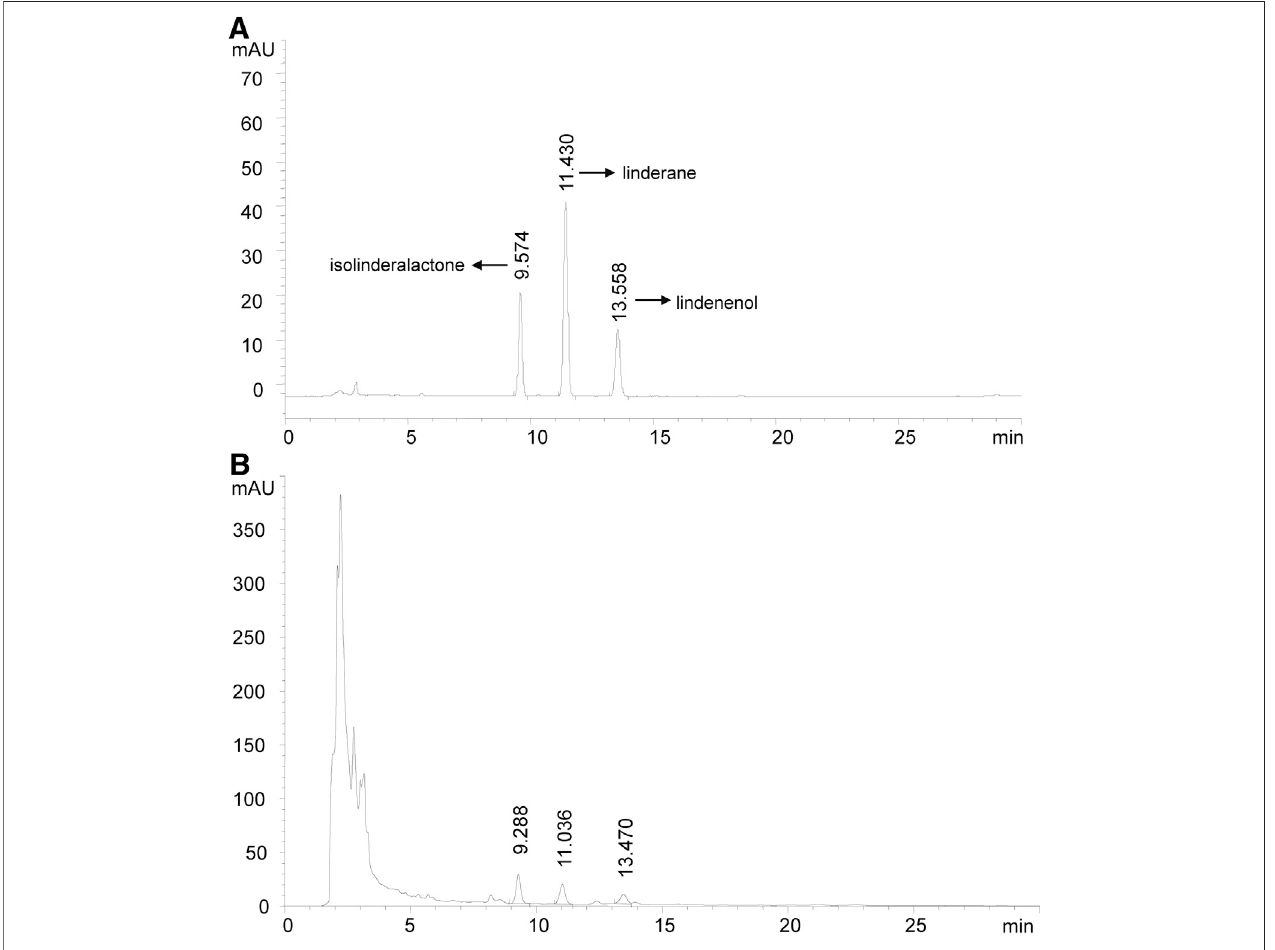
FIGURE 1 | High-performance liquid chromatography chromatogram (HPLC). Isolinderalactone shows the earliest peak time. Therefore, the description of FIGURE 1A needs to be modi fi ed as follows. (A) The HPLC pro fi le of standard isolinderalactone, linderane,and lindenenol are shown with a peak of 9.574, 11.430, and 13.558 min, respectively. (B) TheHPLCpro fi leofLREEispresentedwithapeakat9.288,11.036,and13.470 min.Theyhadsimilarretentiontimes,whichshowedtheymightbehomologs.